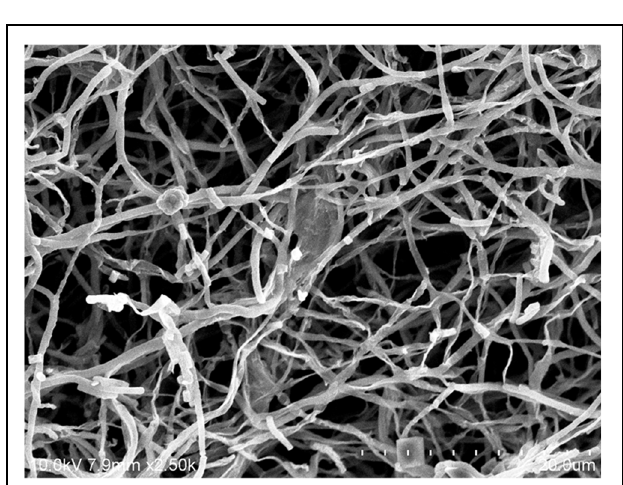
FIGURE 2 | Scanning electron microscope of Streptomyces mangrovisoli MUSC 149 T .